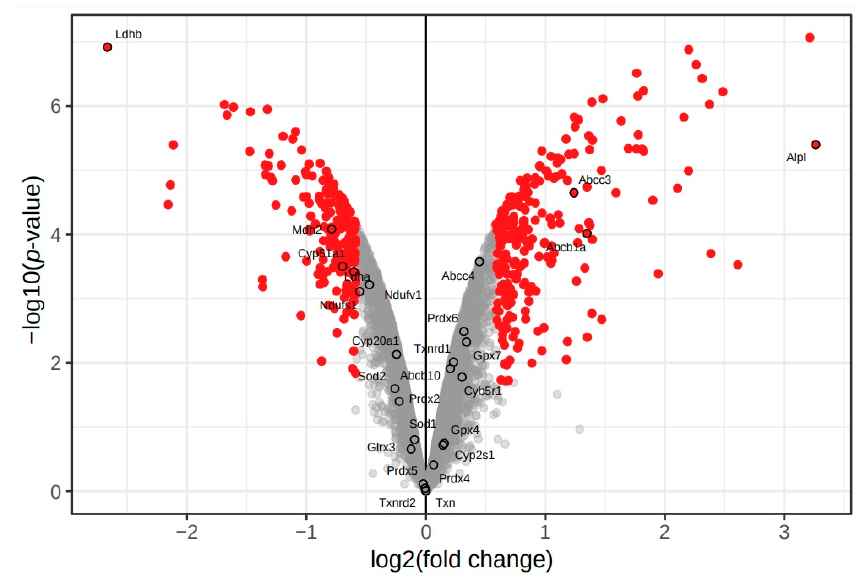
Figure 1. The volcano plot illustrates signi fi cantly changed protein levels in TPZ-resistant MH22a cells compared to the parental cell line. Highlighted in red are signi fi cantly down- and upregulated proteins (fold-change of at least 50% and false discovery rate < 0.05). Proteins not listed in Tables 1–3 but those mentioned in the text are marked with empty black circles.